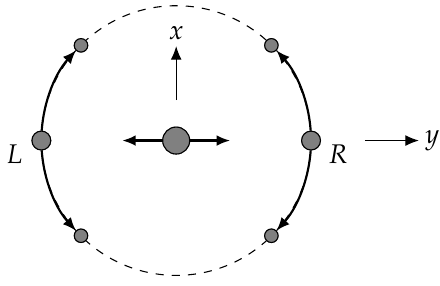
Figure 1. Trajectory of atoms in Sagnac interferometer. A condensate, represented by gray disks, starts in the center of the harmonic trap at time t = 0. A standing-wave laser oriented along y splits the condensate into two packets that move in the y directions. One quarter period later, the atoms ± come to rest on the left (L) and right (R) sides of the trap. Another standing-wave laser oriented along x then splits the atoms again. The resulting packets have the correct velocity to travel in a circular orbit around the trap center. After n complete orbits, the x -laser is applied again. This brings some of the moving atoms back to rest on their respective sides of the trap. The fraction brought to rest depends on the phase difference between the two interfering